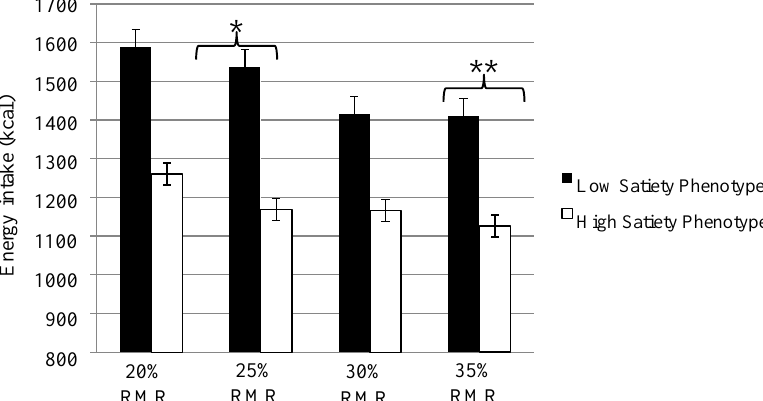
Figure 1. Energy intake (kcal) from the ad libitum lunch test meal for the low and high satiety phenotype across the 20%, 25%, 30% and 35% resting metabolic rate (RMR) conditions. * p < 0.05, ** p < 0.01.